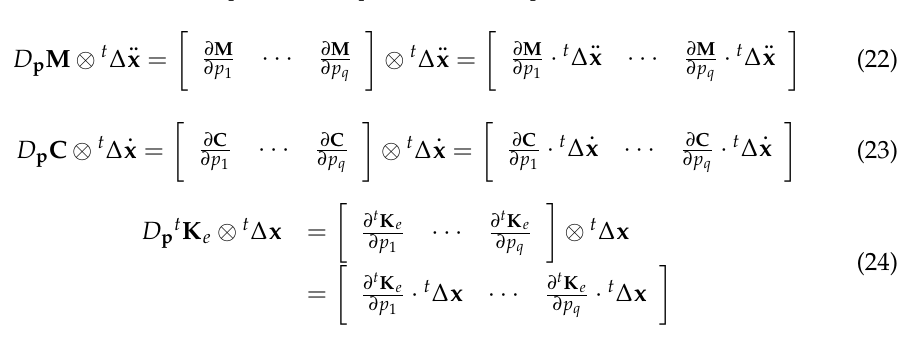
Algorithm 1. Pseudo-code for initial transient response sensitivity